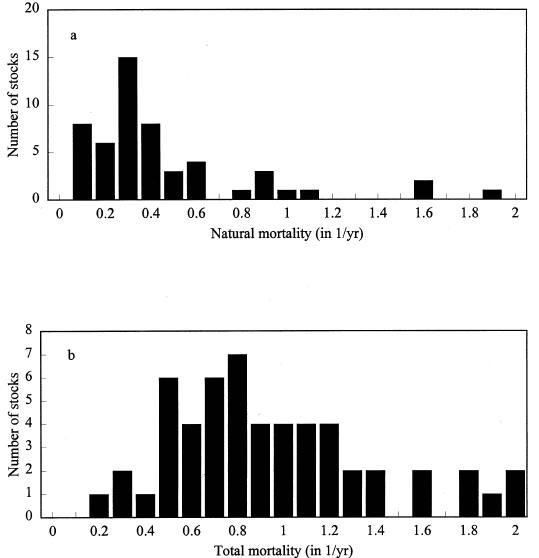
Fig. 8. (a) Natural and (b) total mortality rates for a variety of fish stocks in Hellenic waters.